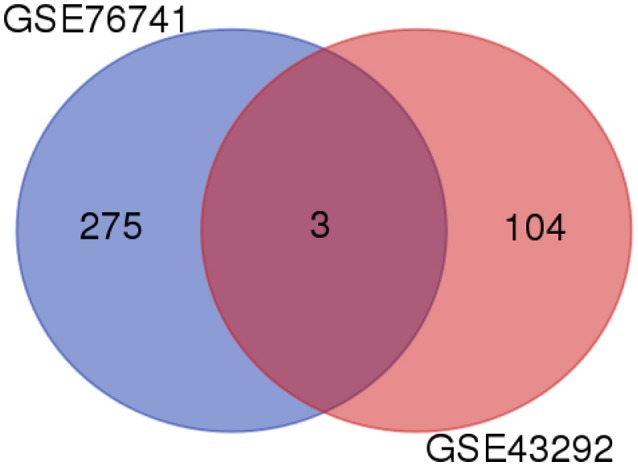
Venn diagram analysis of DEGs. Venn diagram of DEGs is presented in the pairwise melanic-typical comparisons. DEGs, Differentially expressed genes.